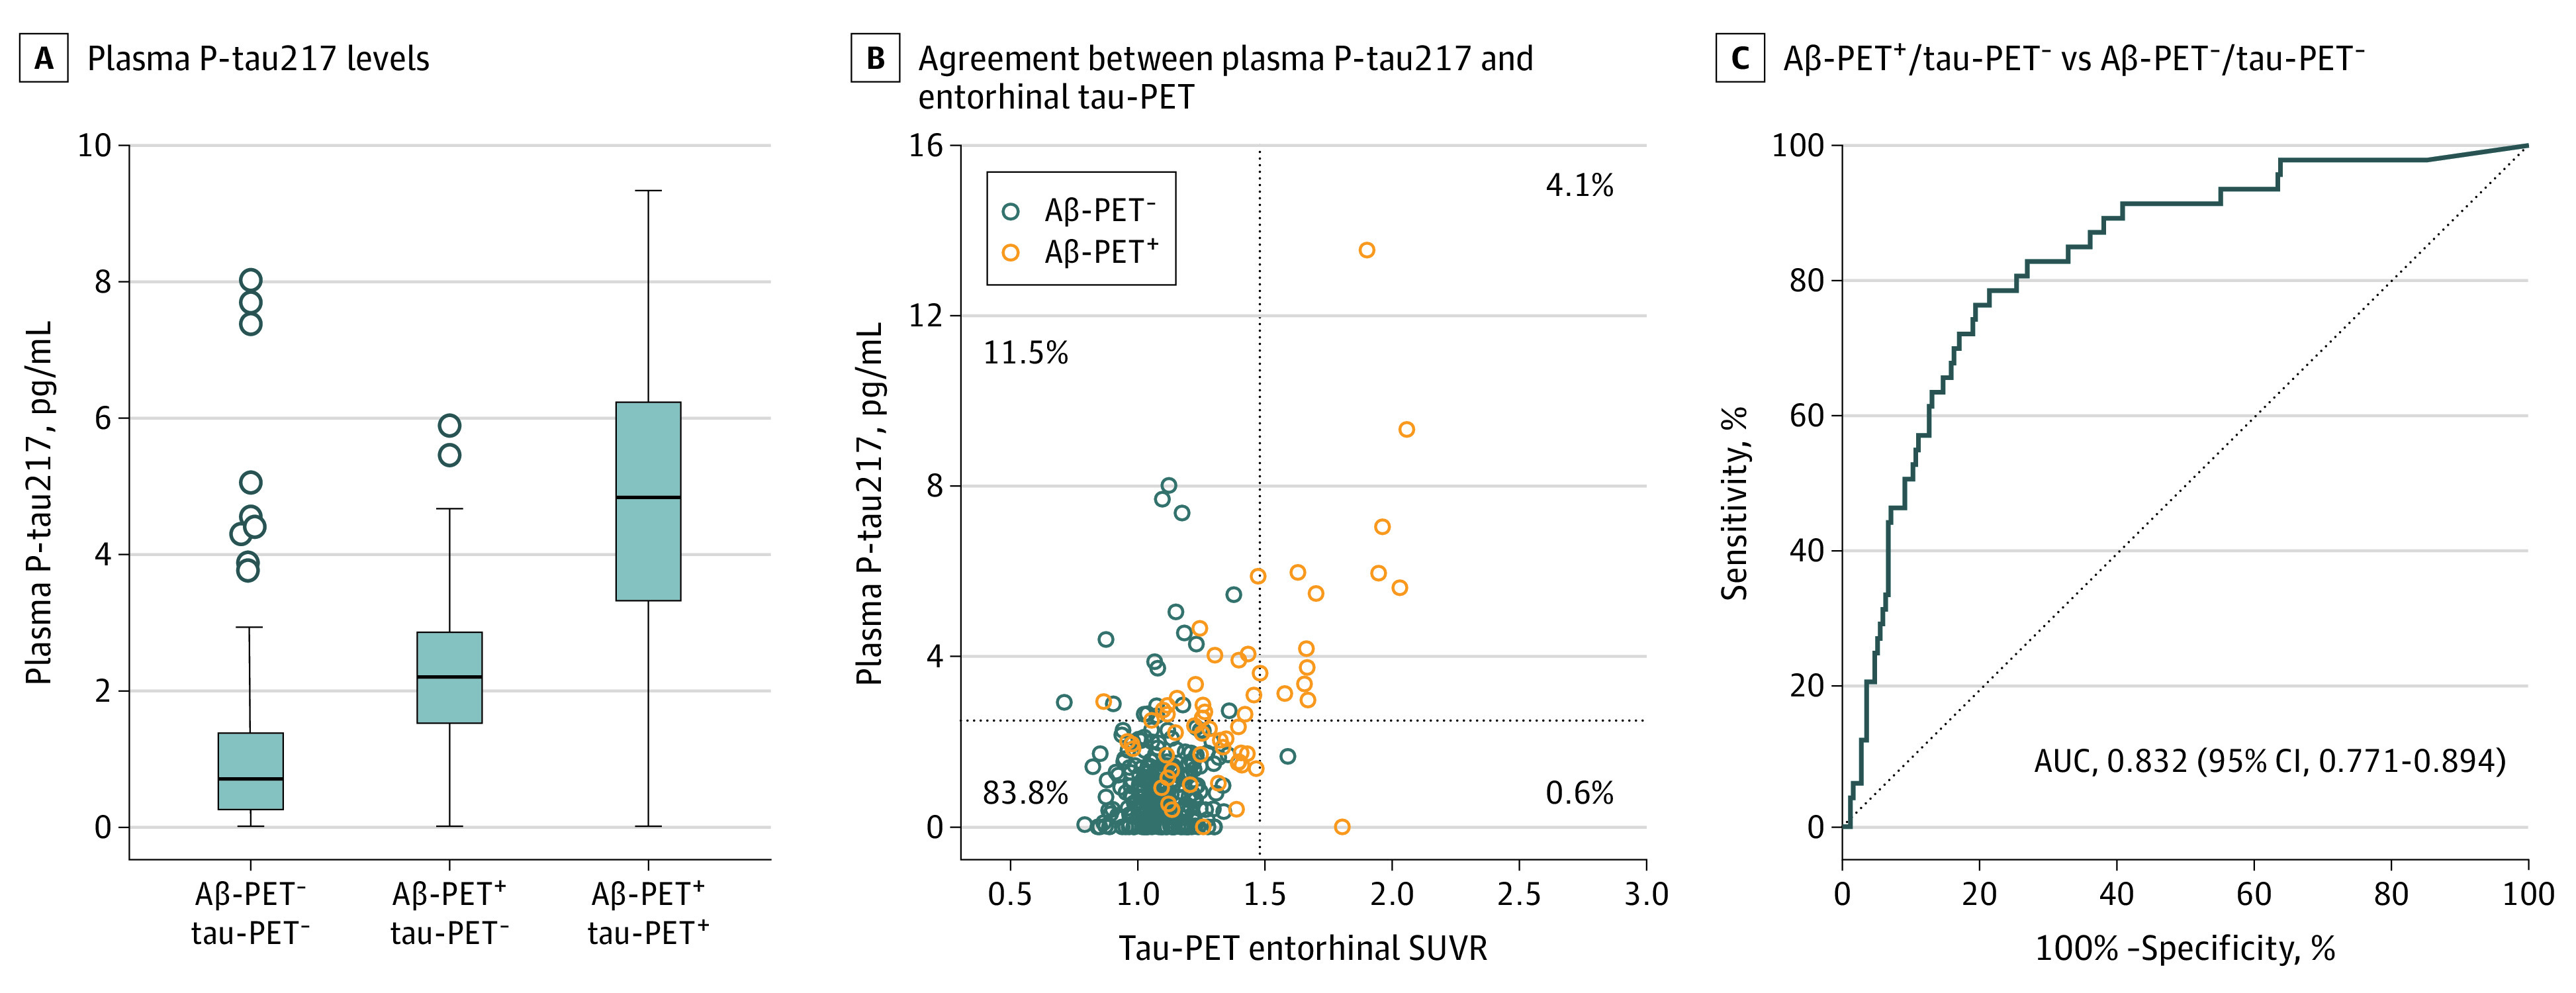
Plasma Tau Phosphorylated at Threonine 217 (P-tau217) and Tau–Positron Emission Tomography (PET) Positivity in the Entorhinal Cortex of Cognitively Unimpaired ParticipantsA, Plasma P-tau217 levels in participants with amyloid-β (Aβ)–PET–/ tau-PET– (n = 252), participants with Aβ-PET+/ tau-PET–(n = 47), and participants with Aβ-PET+/ tau-PET+ (n = 14) (P < .001 for Aβ-PET+/ tau-PET– vs Aβ-PET–/tau-PET– and Aβ-PET+/tau-PET+ vs Aβ-PET–/ tau-PET–). P values are from univariate general linear models adjusted for age and sex as described in the Methods section. Boxes indicate 25th to 75th percentiles, center lines indicate median, whiskers extend to the upper and lower adjacent values or the most extreme points within 1.5 × interquartile range of the 25th and 75th percentiles, and dots indicate outliers. B, Agreement between plasma P-tau217 and entorhinal tau-PET. The dotted lines represent cutoffs for plasma P-tau217 (2.5 pg/mL) and entorhinal tau-PET (standardized uptake value ratio [SUVR], 1.48). C, Receiver operating characteristic curve analysis for differentiating participants with Aβ-PET+/ tau-PET– (n = 47) from those with Aβ-PET–/ tau-PET– (n = 252). Cutoffs for plasma P-tau217, entorhinal tau-PET, and Aβ-PET (SUVR, 0.53) were determined as described in the Methods section. AUC indicates area under the curve.